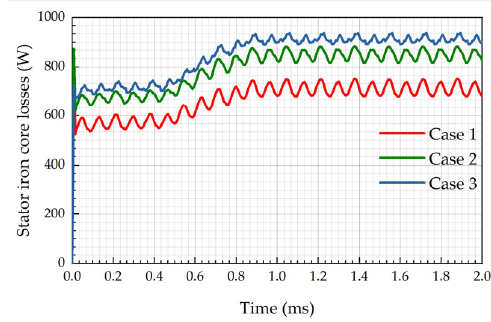
Figure 16. Stator iron ‐ core losses in the three cases at rated load.